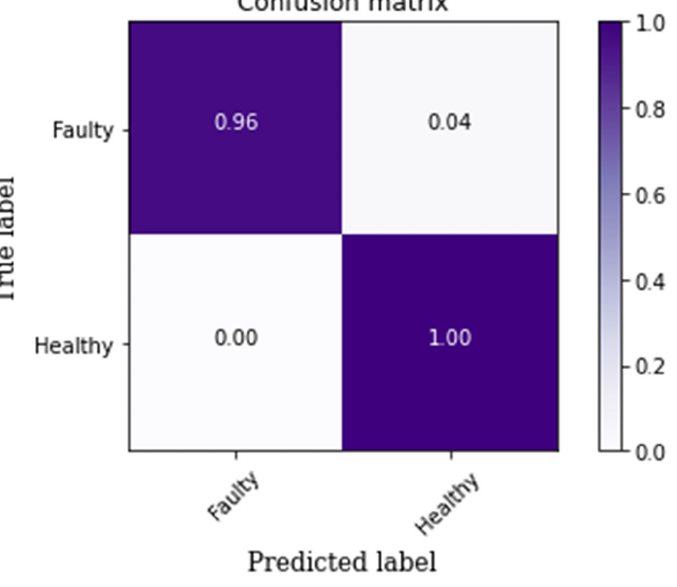
Figure 10. Simple motion-based CM for the proposed TL-based FDD approach.